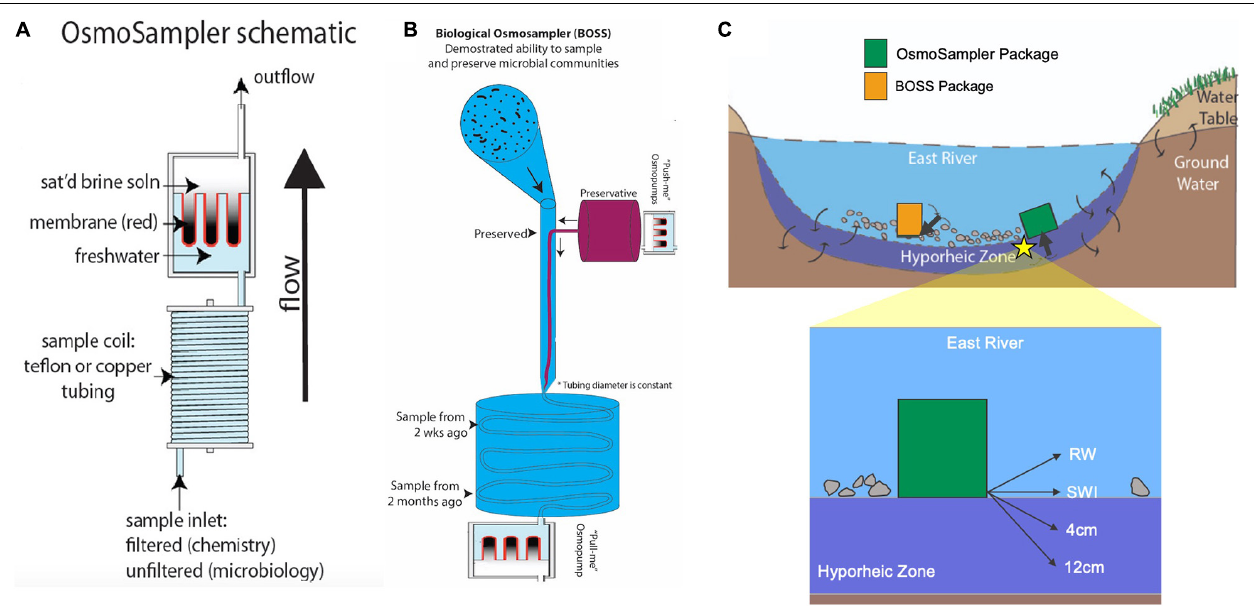
FIGURE 2 | (A) OsmoSampler schematic showing pump, sample coil, and sample inlet. (B) Illustration of Biological OsmoSampler function. (C) River cross-section showing sampling schematic depicting OsmoSampler and BOSS packages and inlet ports (highlighted arrows). Star indicates location of close-up schematic of inlet port locations within the hyporheic zone and water column. Schematics are not to